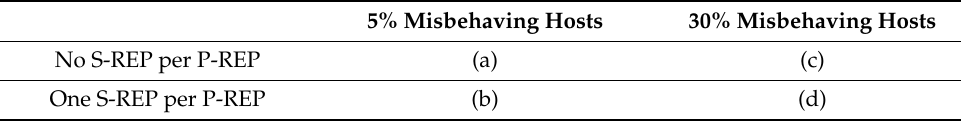
Table 2. Four cases with misbehaving